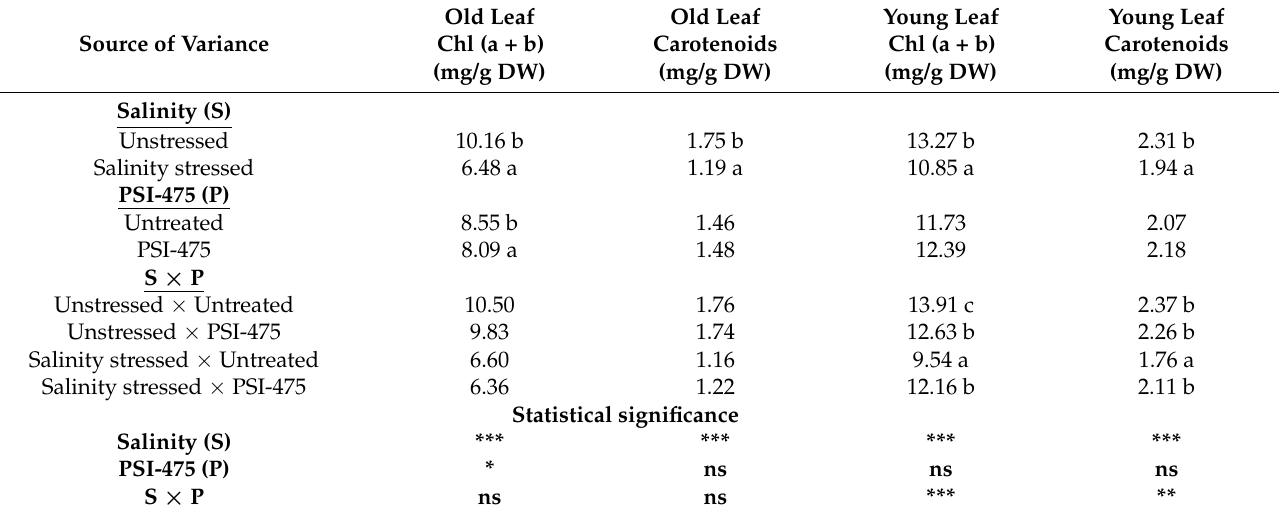
Table 6. Effect of salinity stress and PSI-475 on photosynthetic pigments content in tomato leaf